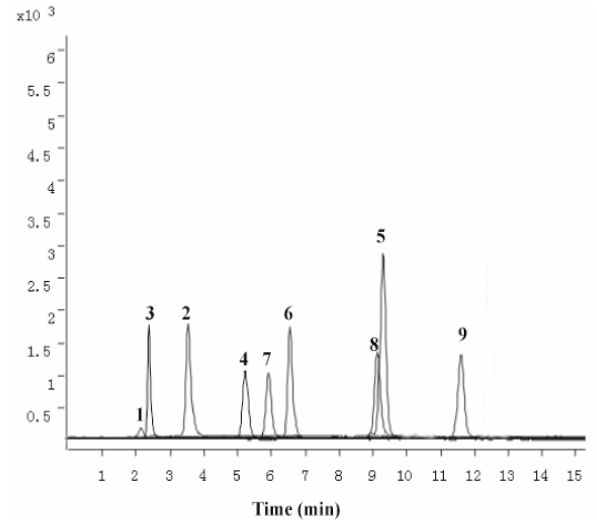
Figure 1. The multiple reaction monitoring (MRM) chromatograms of 10 standards of mixed standards. notoginsenoside R1( 1 ), ginsenoside Rb1 ( 2 ), ginsenoside Rg1 ( 3 ), cholic acid ( 4 ), deoxycholic acid ( 5 ), hyodeoxycholic acid ( 6 ), ursodesoxycholic acid ( 7 ), chenodeoxycholic acid ( 8 ), muscone ( 9 ).